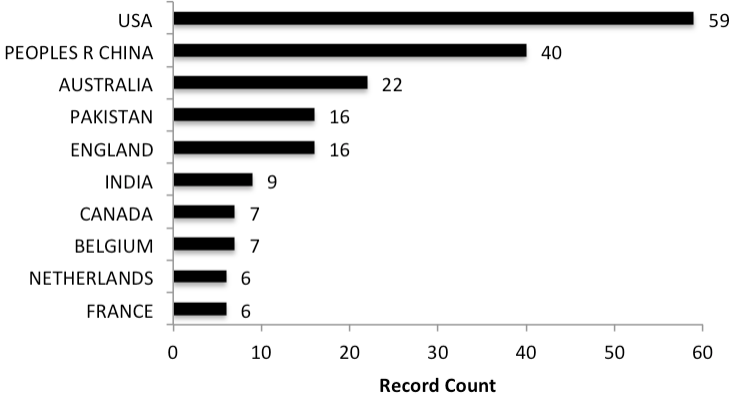
Figure 4. The highest contributing countries to the ‘thriving at work’ concept.